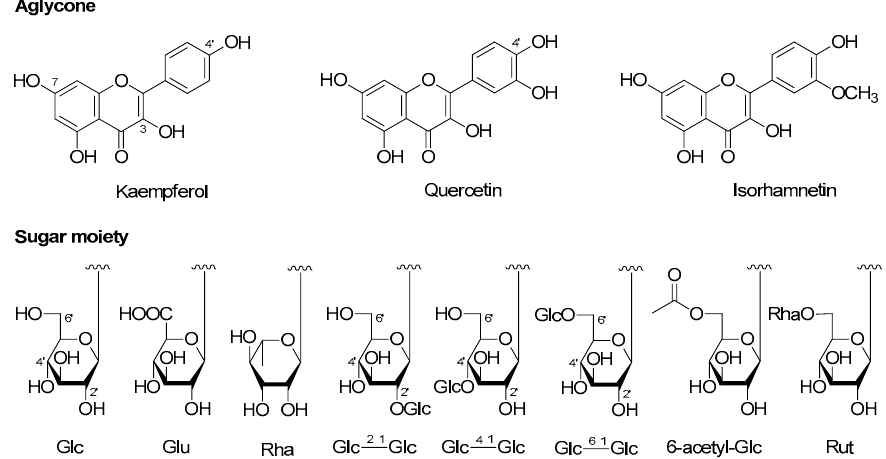
Figure 5. The structure of aglycones and glycosyls of flavonoids from the aerial parts of A. mongolicum .